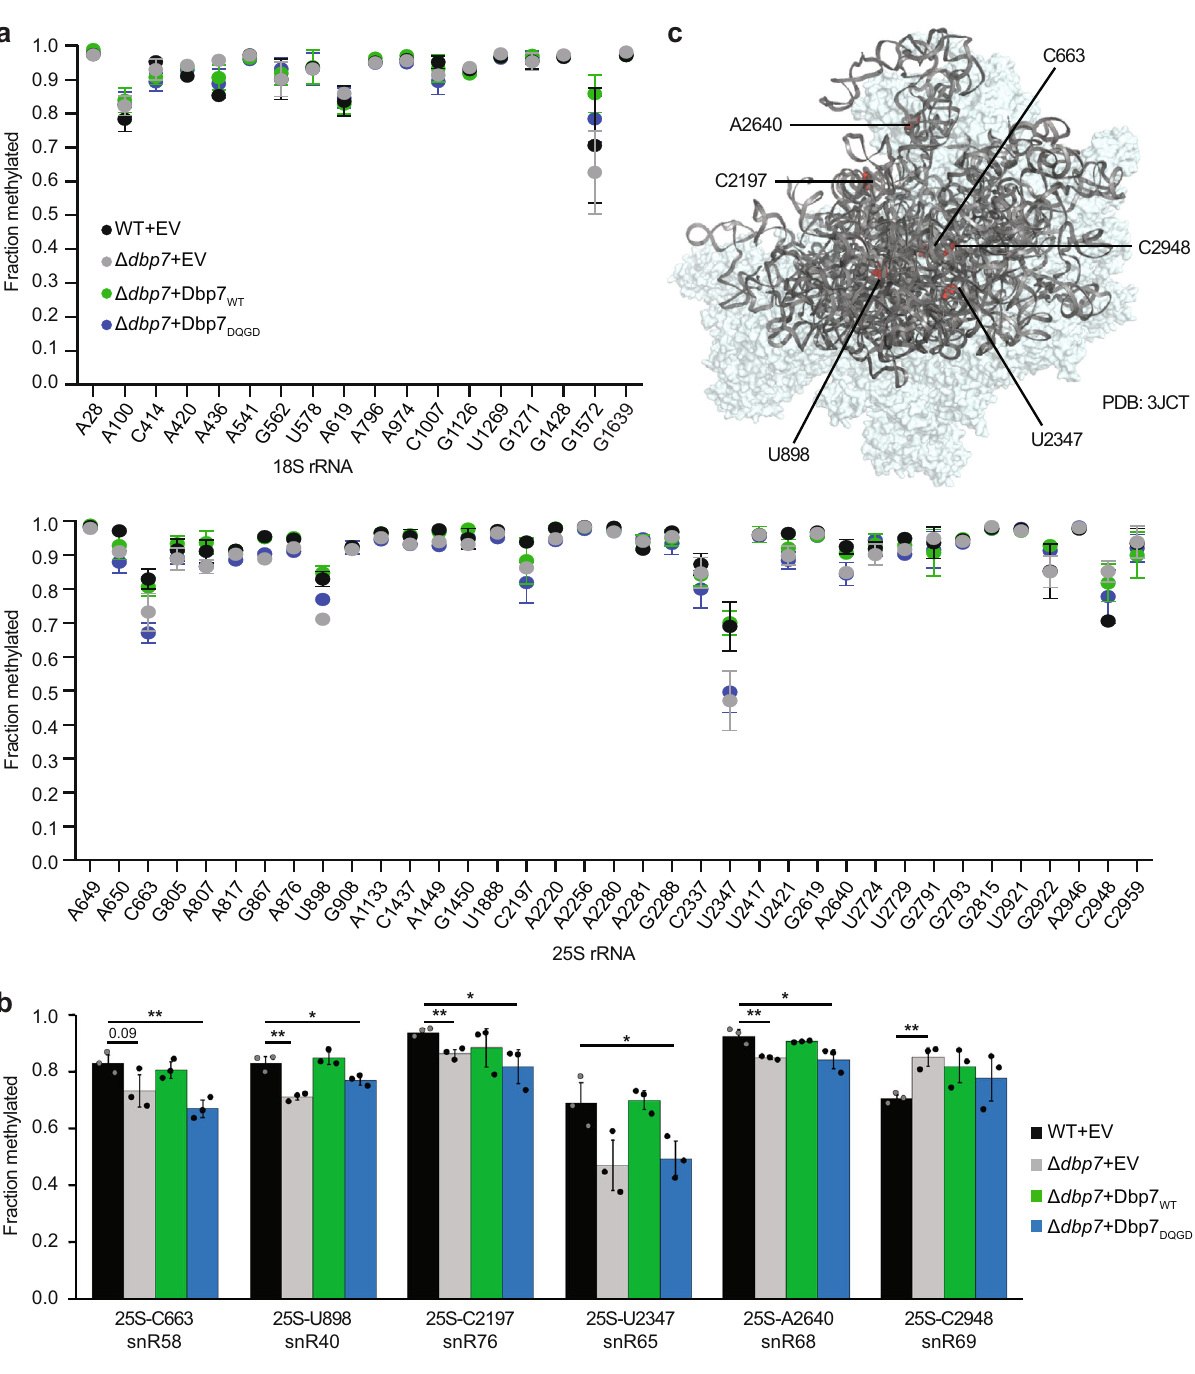
Fig. 2 Dbp7 is required for ef fi cient 2 ′ - O -methylation of speci fi c rRNA nucleotides. a Total RNA extracted from exponentially growing cells from the strains of the Δ dbp7 complementation system was used for RMS analysis. Experiments were performed in triplicate (see Source data for individual data points) and the mean RMS score plotted for each 2 ′ - O -methylated nucleotide in the 25S and 18S rRNAs. Error bars represent standard deviation. b Bar graphs of the RMS scores for each of the four strains at sites where the extent of 2 ′ - O -methylation varies signi fi cantly are shown. Data from n = 3 independent measurements are presented as mean ± standard deviation. Statistical signi fi cance was calculated using unpaired, two-tailed Student ’ s t -test (C663 WT + EV vs Δ dbp7 + EV p = 0.09432, WT + EV vs Δ dbp7 + Dbp7 DQGD p = 0.005907; U898 WT + EV vs Δ dbp7 + EV p = 0.00289, WT + EV vs Δ dbp7 + Dbp7 p = 0.037832; C2197 WT + EV vs Δ dbp7 + EV p = 0.005727, WT + EV vs Δ dbp7 + Dbp7 DQGD Δ dbp7 + Dbp7 p = 0.043687; A2640 WT + EV vs Δ dbp7 + EV p = 0.007783, WT + EV vs Δ dbp7 + Dbp7 DQGD Δ dbp7 + EV p = 0.004162; * p < 0.05, ** p < 0.01). c The positions of nucleotides carrying 2 ′ - O -methylations signi fi cantly affected by lack of Dbp7 are indicated on a pre-60S particle puri fi ed via TAP-tagged Nog2 (PBD:3JCT) 25